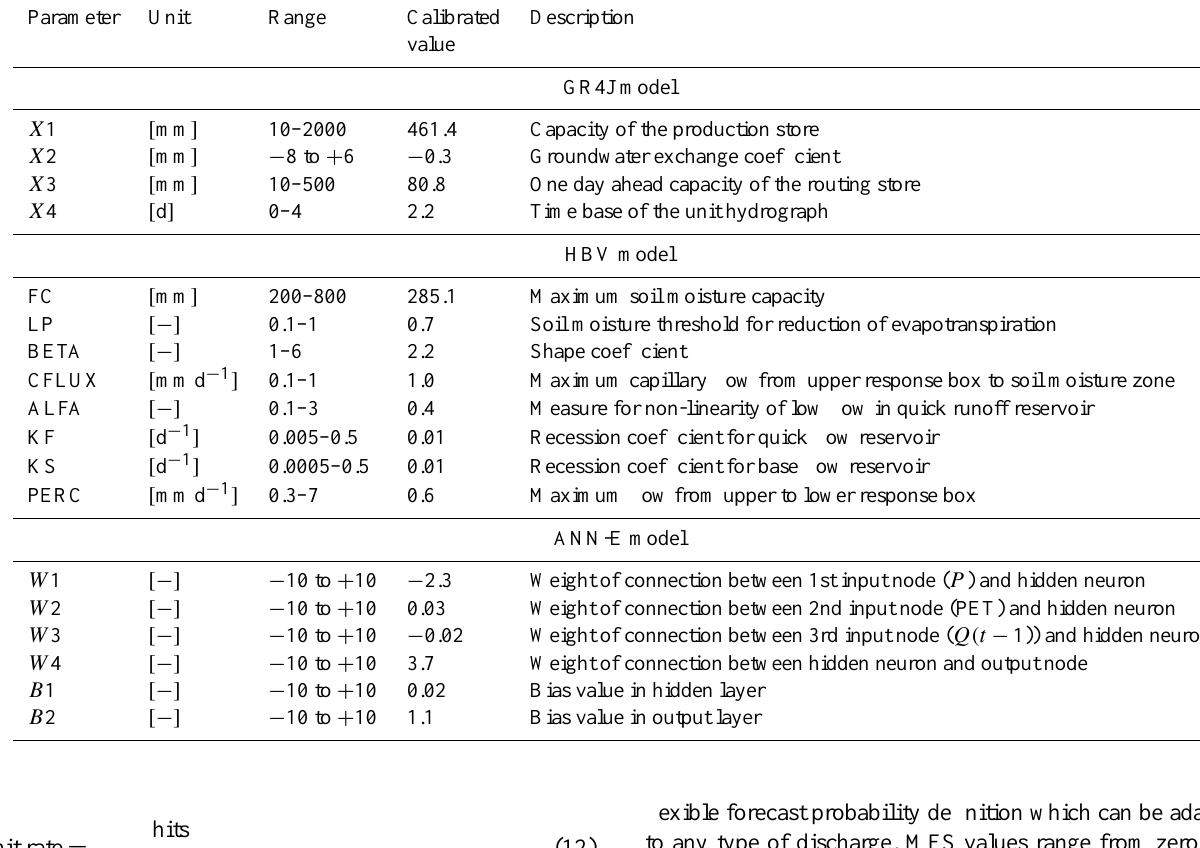
Table 6. Parameter ranges and calibrated values of the pre-selected three models.